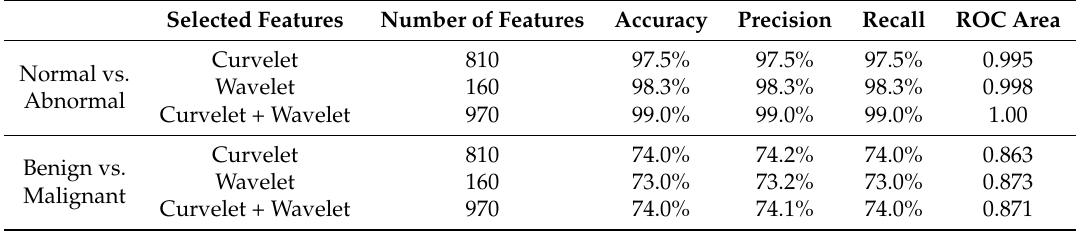
Table 2. The classification performance without applying the binary grey wolf optimizer (BGWO). Selected Features Number of Features Accuracy Precision Recall ROC Area Curvelet 810 Normal vs. Abnormal Curvelet Benign vs. Malignant